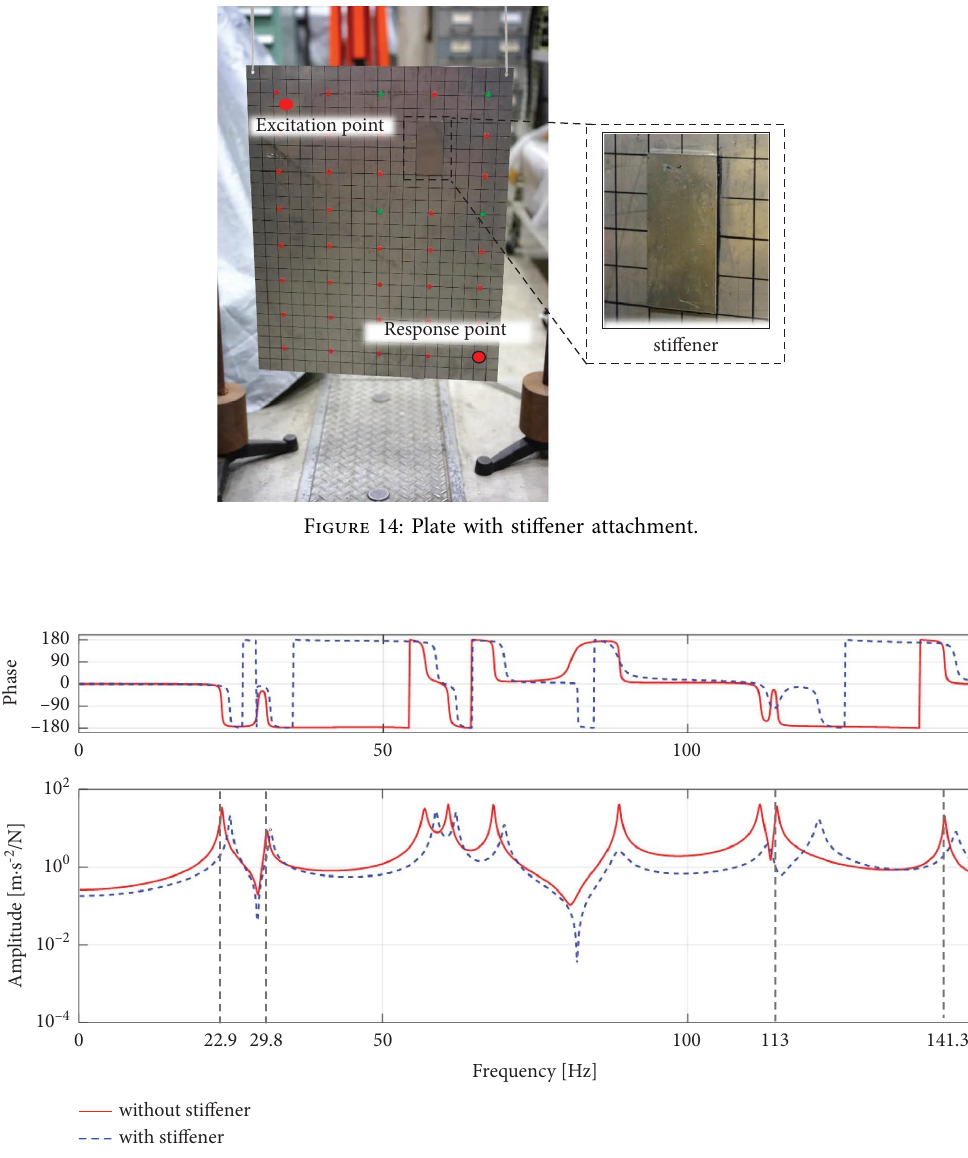
Figure 15: Target FRF before and after a downward trend at 4 selected frequencies marked at curve ftting with same modal damping ratio as shown in frequency axis. Te most remarkable peak shift and dec- Figure 16. Te result shows an overall peak shift to higher rement happened at third selected frequency (113 Hz) since frequency range by stifener attachment, and this also makes